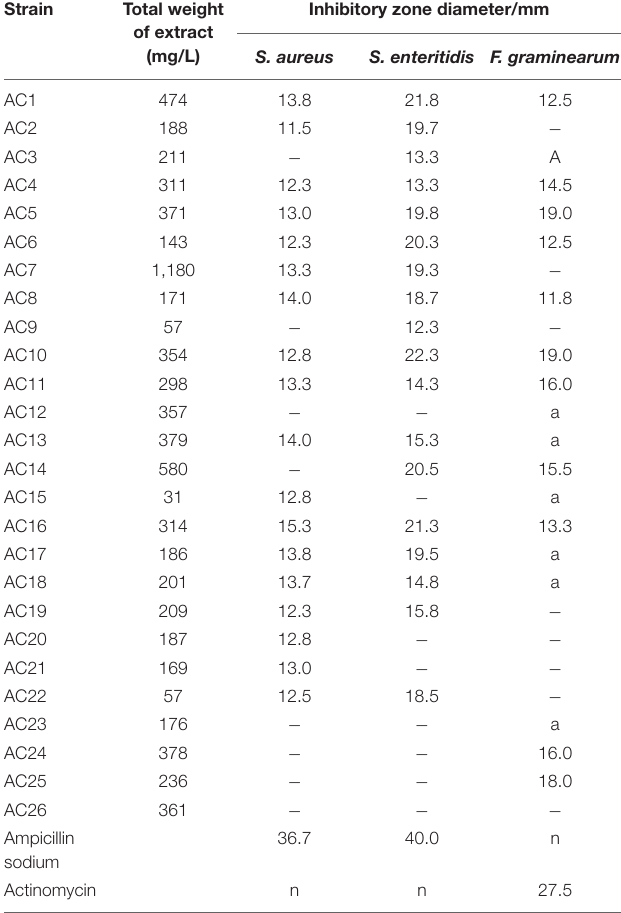
TABLE 2 | Yields and antimicrobial activities of the crude extracts from endophytic